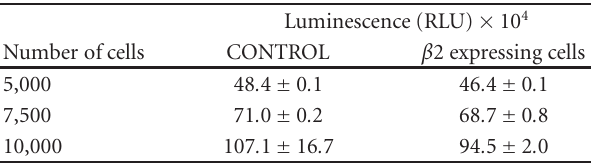
Table 1: Proteasome activity in cells that over-express the β 2 subunit of the proteasome.